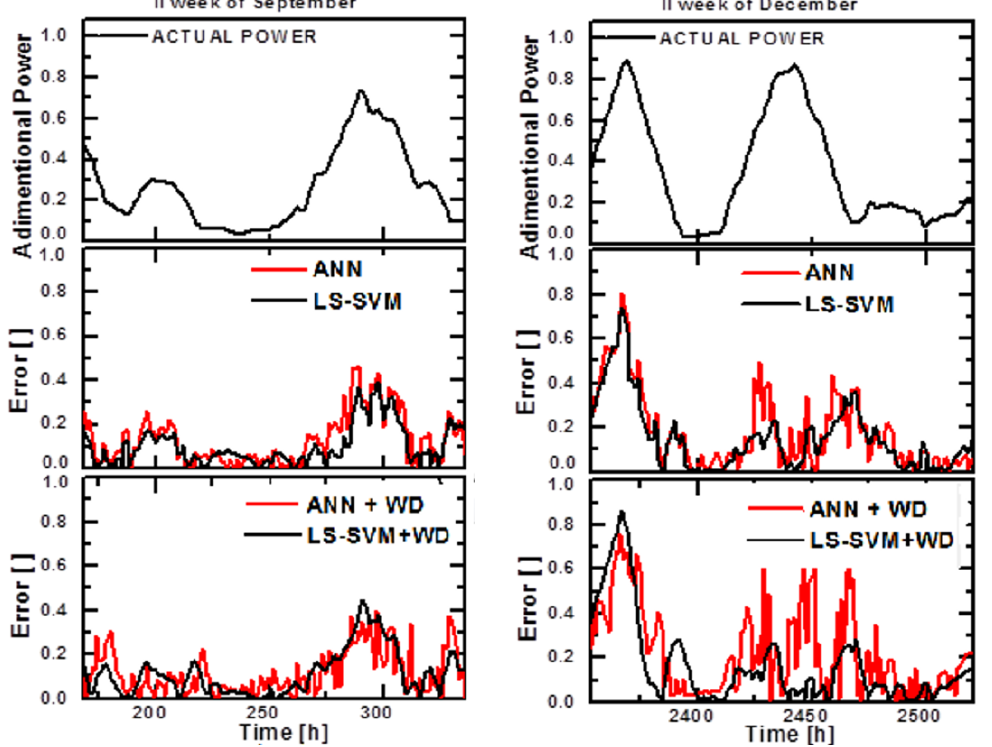
Figure 10. Error Ei and actual wind power in two different weeks of year.